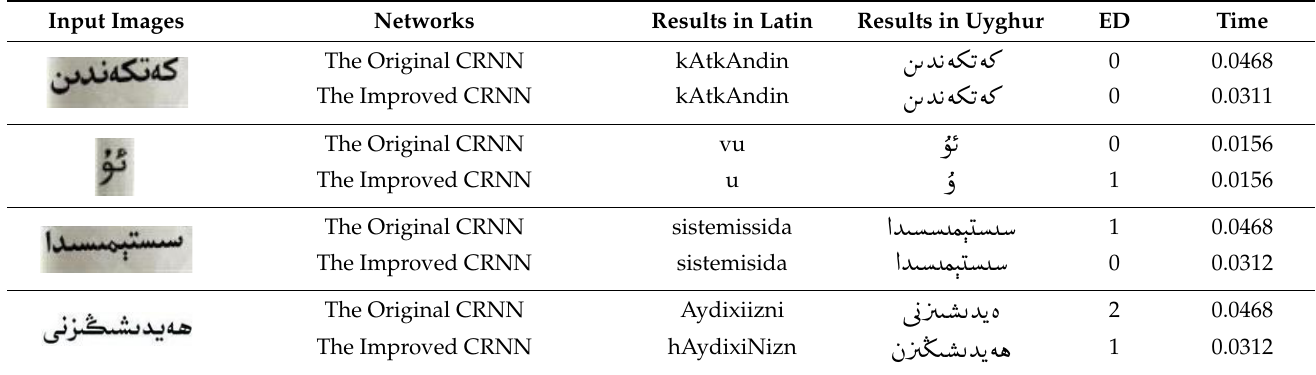
Table 6. The evaluation results using different methods. Input Images